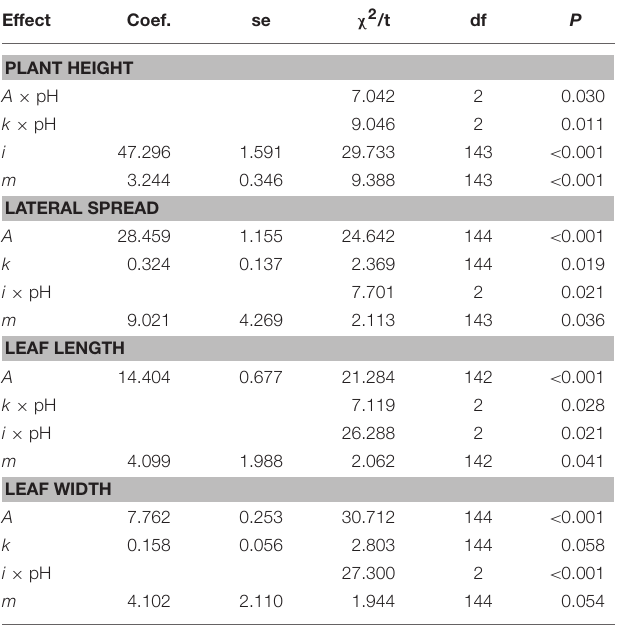
TABLE 1 | Final NLMM of the growth